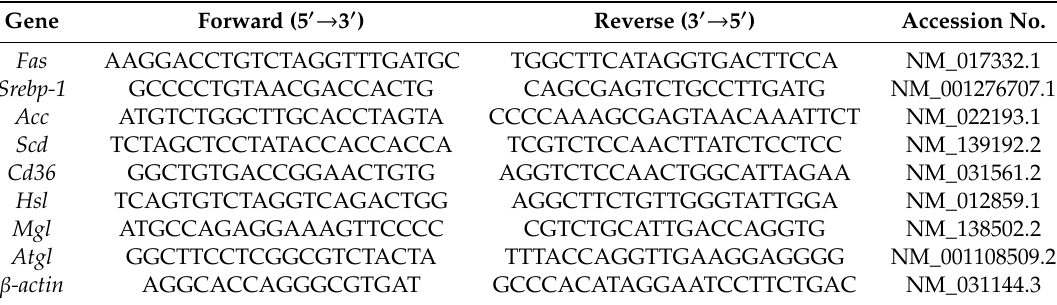
Table 1. Real-time PCR primer